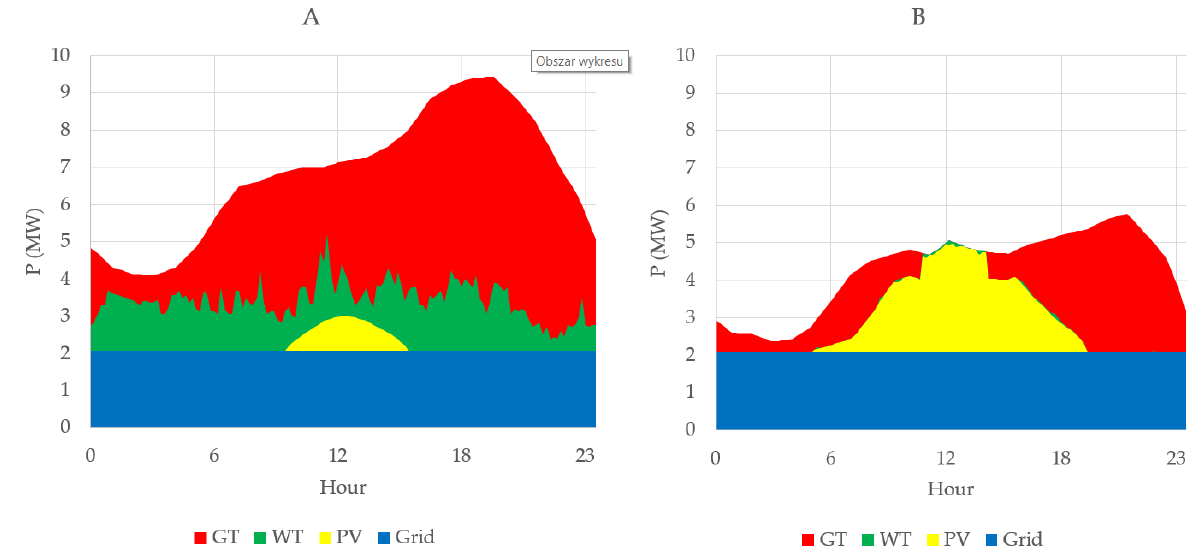
Figure 8. Demand coverage by electricity sources on exemplary days for RES power variant of 10 MW: ( A ) 4 January, and ( B ) 4 July.